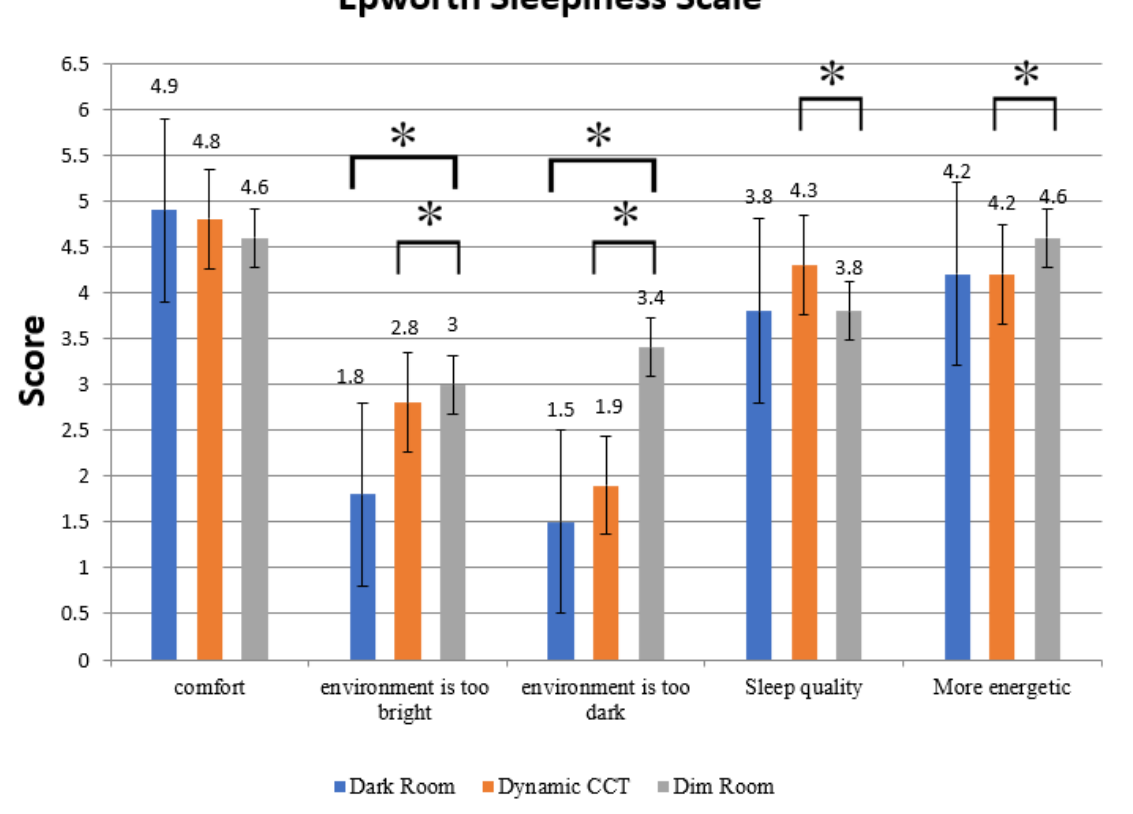
Figure 14. Dark room, Dynamic CCT and Dim light typing efficiency comparison chart per minute in sleep environment. “*” is p < 0.05.